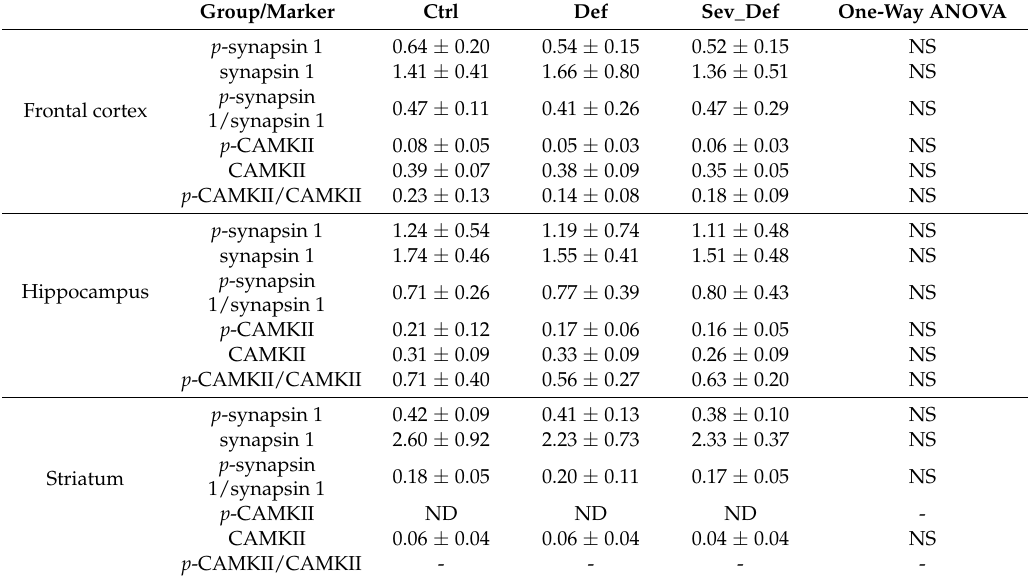
Figure 4. Brain-derived neurotrophic factor levels in the frontal cortex, hippocampus and striatum. Frontal cortex ( A ), the hippocampus ( B ) and the striatum ( C ) as measured by ELISA. No differences between groups were detected in any of the brain areas. One-wayANOVA with Tukey’s multiple comparison test, n = 6–10, mean ± SD. Ctrl: Control animals, Def: Vitamin C deficient animals, Sev_def: Severely vitamin C deficient animals. Table 3. Synaptic plasticity markers in the frontal cortex, hippocampus and striatum. Group/Marker Ctrl Def